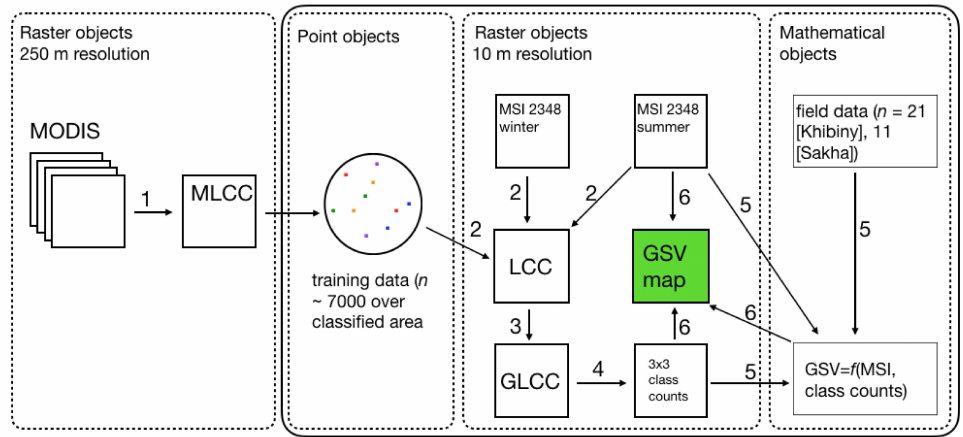
Figure 4. Workflow of GSV modelling. MODIS data are classified (1) to produce a land cover classification (MLCC) from which point training data are extracted within the VEGA system. The solid rectangle shows the new method: The point data are used to train (2) a classifier operating on the 10-m resolution bands (2, 3, 4, and 8—band numbers shown within the symbols) of a winter and a summer Sentinel-2 MSI image, with a 10-m resolution land-cover classification (LCC) as output. This is simplified (3) to a generalised land cover classification (GLCC) as described in the text and Table 4, then quantified (4) to generate a multi-band image in which each ‘band’ represents the number of pixels within a 3 × 3 neighbourhood corresponding to a particular class in the GLCC. The GSV estimator function is produced using equation (1), with the summer MSI image and the 3 × 3 class counts image as inputs, trained using field estimates of GSV (5). Finally, the GSV estimates for the whole study area are produced using the estimator function, class counts, and MSI summer image (6).